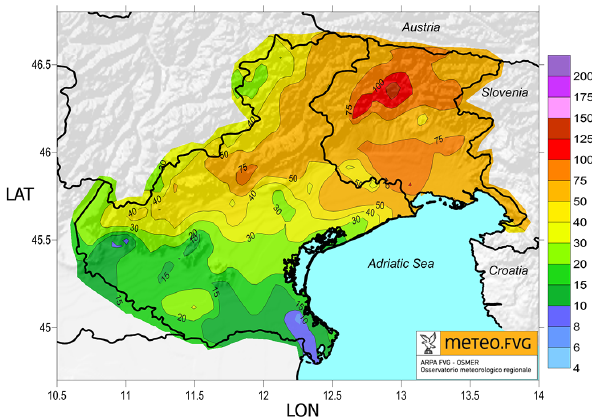
Figure 3. 24h accumulated precipitation (color bar in mm) for 12 September 2012, obtained from hourly raingauge data analyzed with the natural neighbor method: 163 stations in the Veneto re- gion (ARPAV) and 111 stations in the Friuli Venezia Giulia region (OSMER-ARPA FVG). The figure is courtesy of A. Cicogna (OS- MER – ARPA FVG).